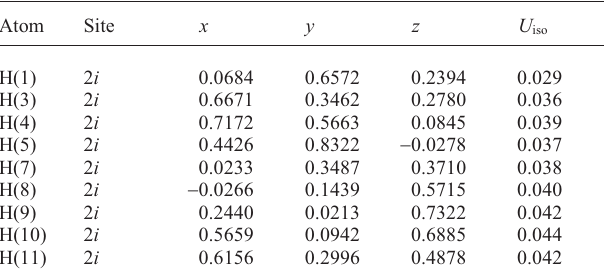
Table 2. Atomic coordinates and displacement parameters (in Å 2 )